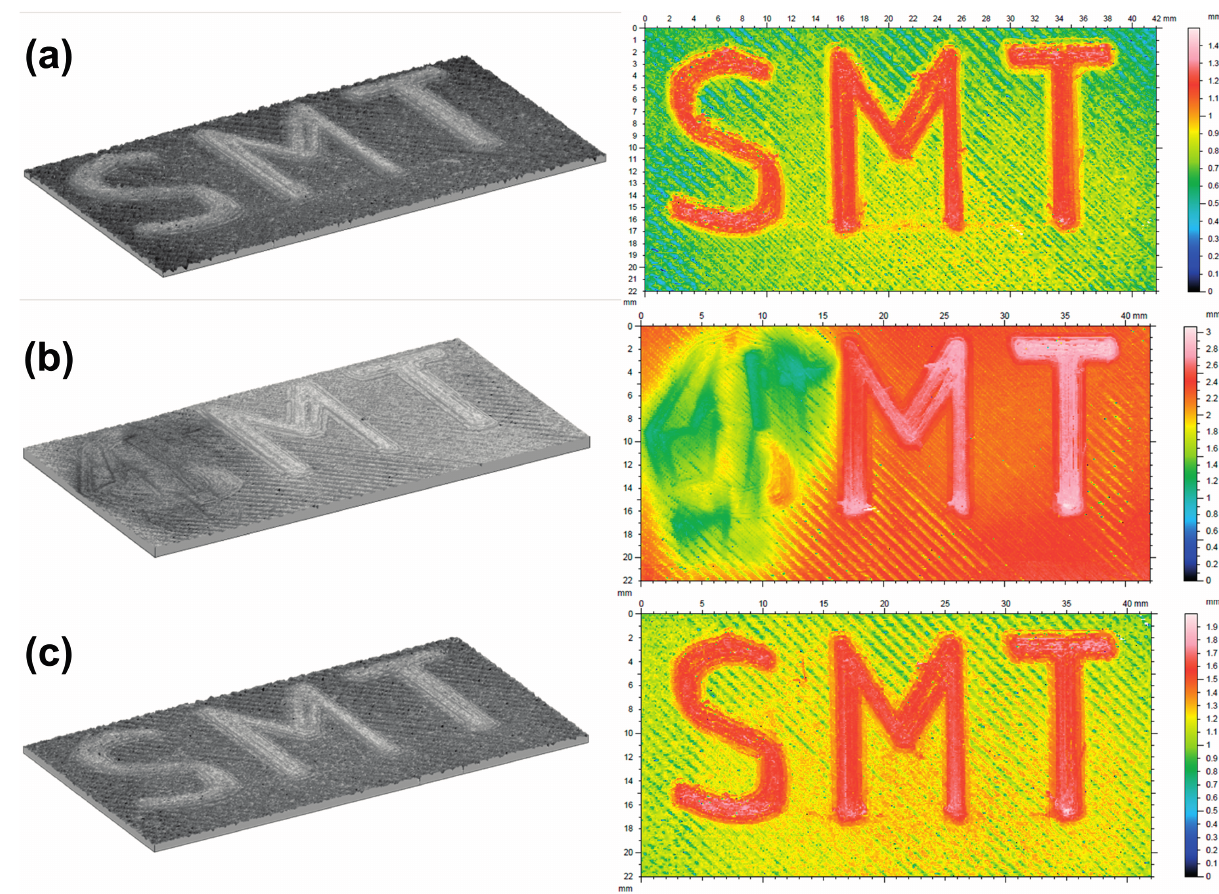
Figure 14. Change of surface morphology in a 3D printed PLA card with “SMT” atop. Left : 3D view; right : top view (3D scanned). ( a ) As printed; ( b ) after “S” is impressed; and ( c ) after heating for shape